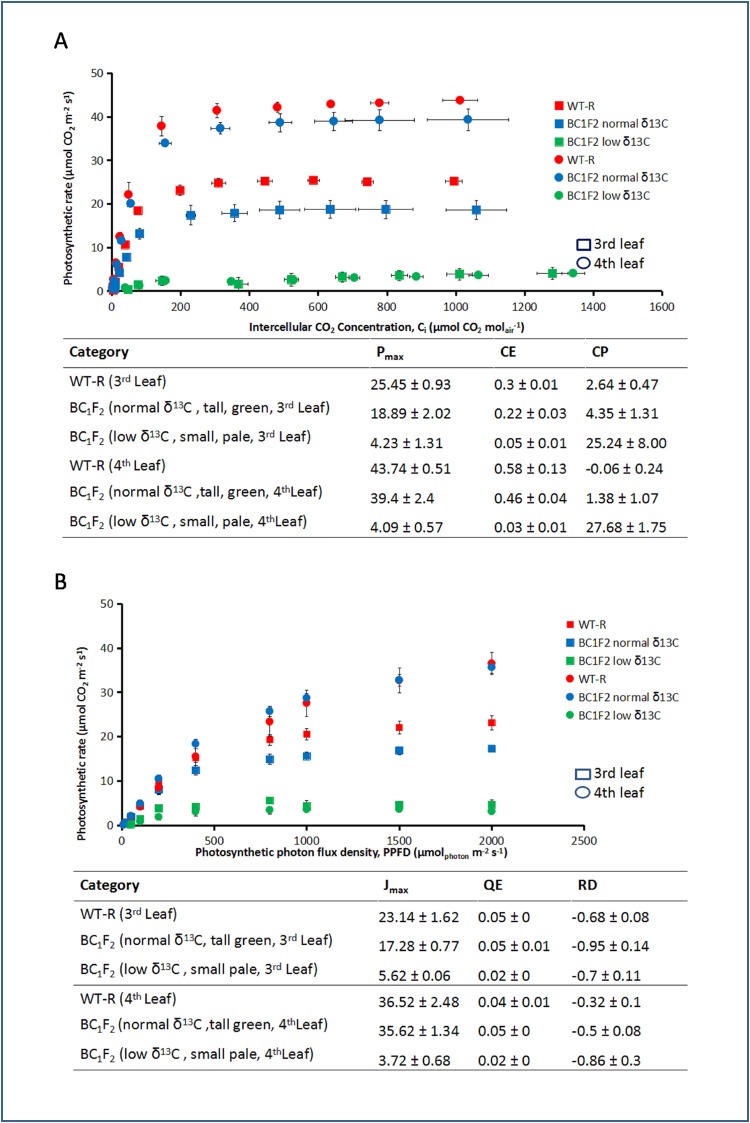
Measurement of photosynthetic parameters of BC1F2 mutants and wild type.(A)The photosynthesis rate per internal CO2 concentration response curves (ACi) for the low δ13CBC1F2 (green square), normal δ13CBC1F2 (blue square) and wildtype (WT) (red square). The maximum rate of photosynthesis (Pmax), carboxylation efficiency (CE) and CO2 compensation points (CP) are shown in the table. However, the CO2 compensation point is high for low δ13C mutants. The squares show data of 3rd leaf and circles for the 4th leaf. The green, blue, and red colors represent low δ13C BC1F2, normal δ13C BC1F2, and WT, respectively. (B)The light response curve (LRC) for the low δ13C BC1F2 (green square) normal δ13CBC1F2 (blue square) and wildtype (red square). The maximum rate of photosynthesis (Jmax), quantum efficiency (QE) and light compensation point (RD) are shown in the table. The squares show data of 3rd leaf and circles of the 4th leaf. The green, blue and red marks represent low δ13C BC1F2, normal δ13C BC1F2, and WT, respectively.